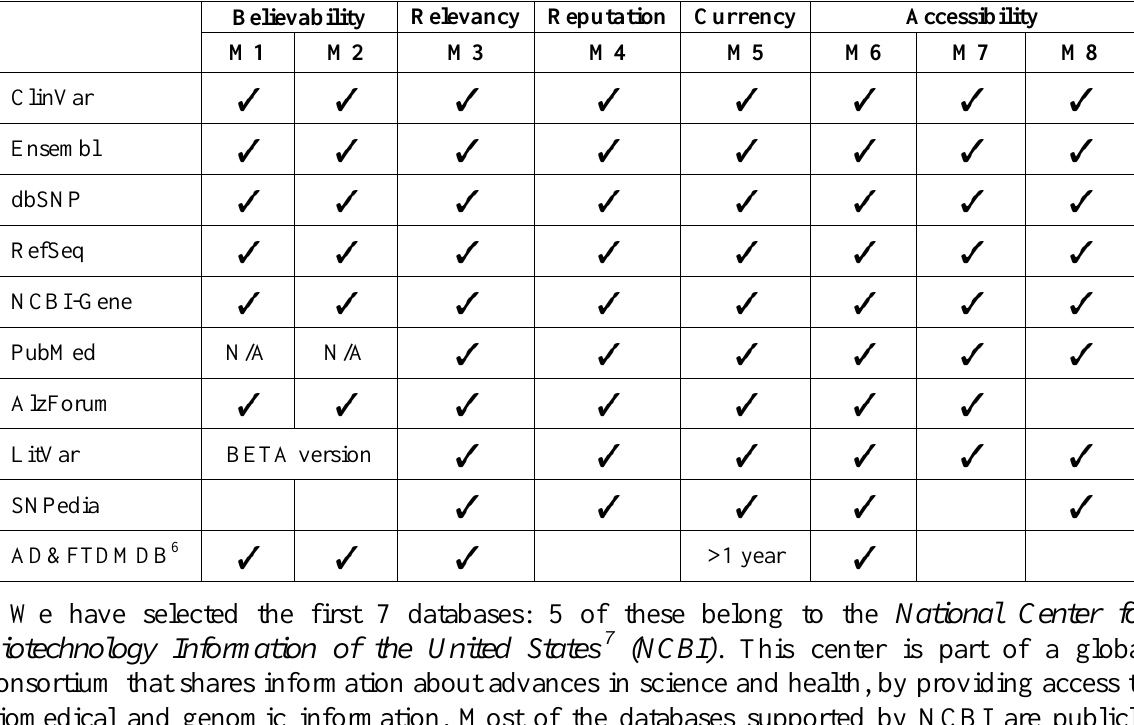
Table 5 . Data Quality Assessment of 10 biological data sources (N/A: Not